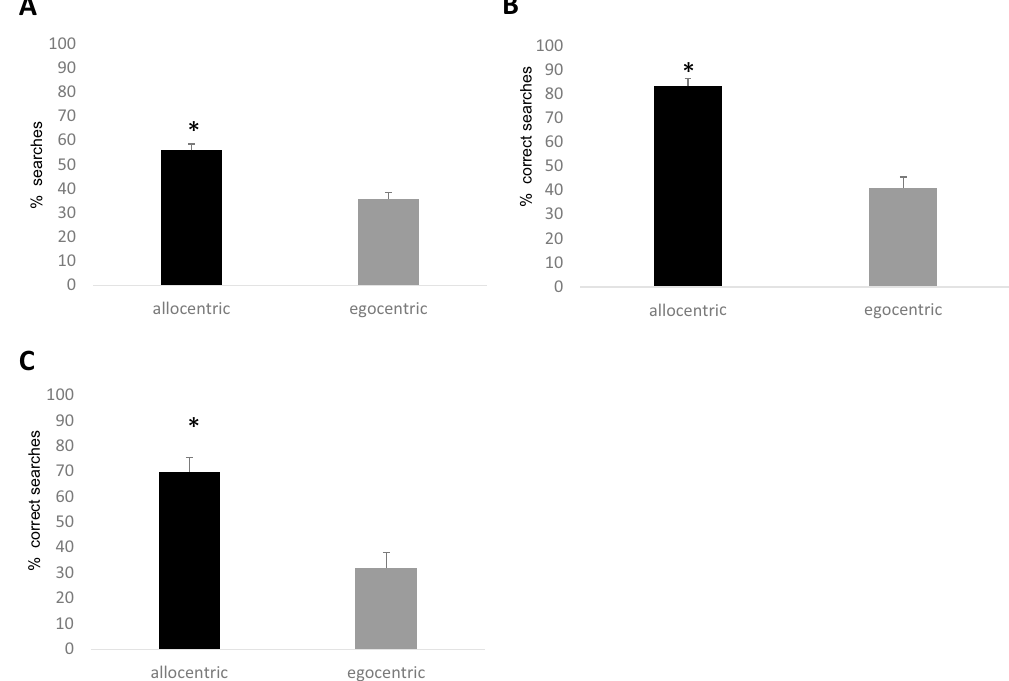
Figure 2. ( A ) Mean percentage of spontaneous allocentric and egocentric searches in Experiment 1. ( B , C ) The mean percentage of correct responses in Experiments 2 and 3. The asterisk indicates the conditions in which bees performed significantly above chance. Bars represent standard